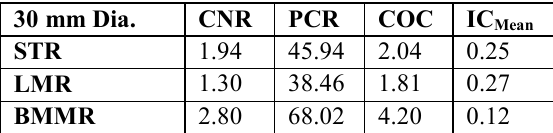
Table-5: CNR, PCR and COC of the conductivit y images of Fig. -9 3 0 mm Dia.